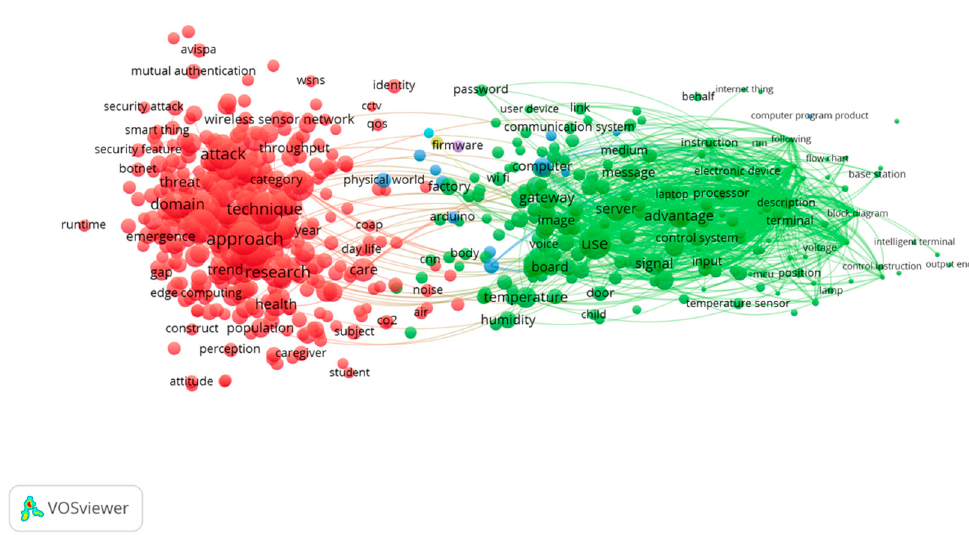
Figure 13. Themes network for 2019.